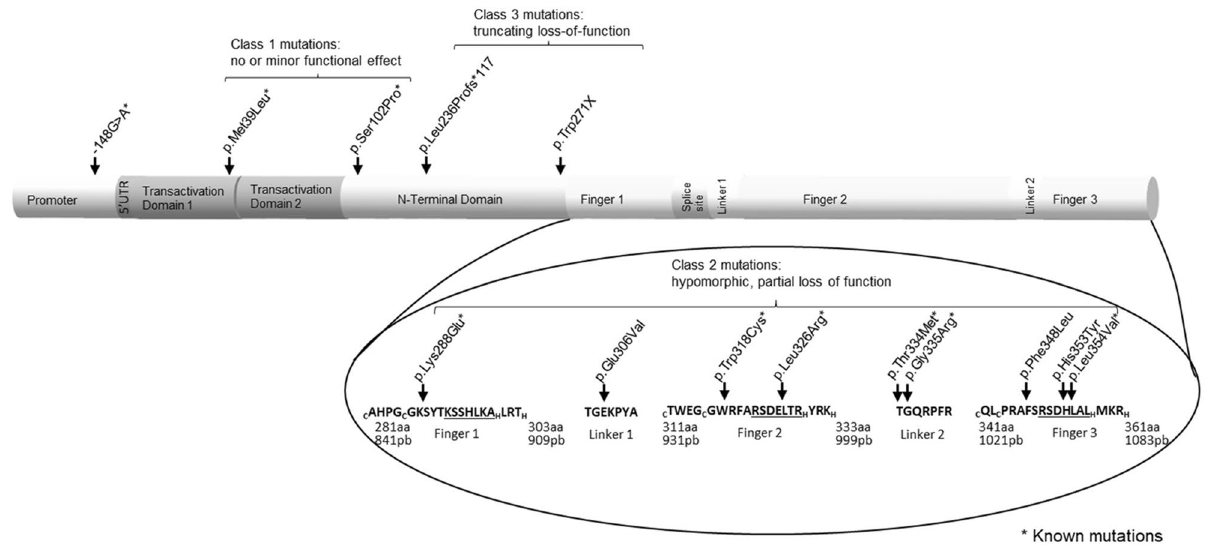
Figure 2. Sequencing KLF1 exons and promoter revealed known and novel variants. Summary of (novel) variants that were found in KLF1 as indicated in Supplementary Table 1. Schematic representation of the KLF1 gene, depicting the promoter, protein binding and the 3 Zinc-finger domains. Variants are indicated by arrows. Inlet zoom displays a detailed overview of the three Zinc-fingers. Letters in superscript indicate amino acids involved in Zinc atom binding. Underlined letters indicate amino acids directly involved in DNA binding. Previously described variants are marked by